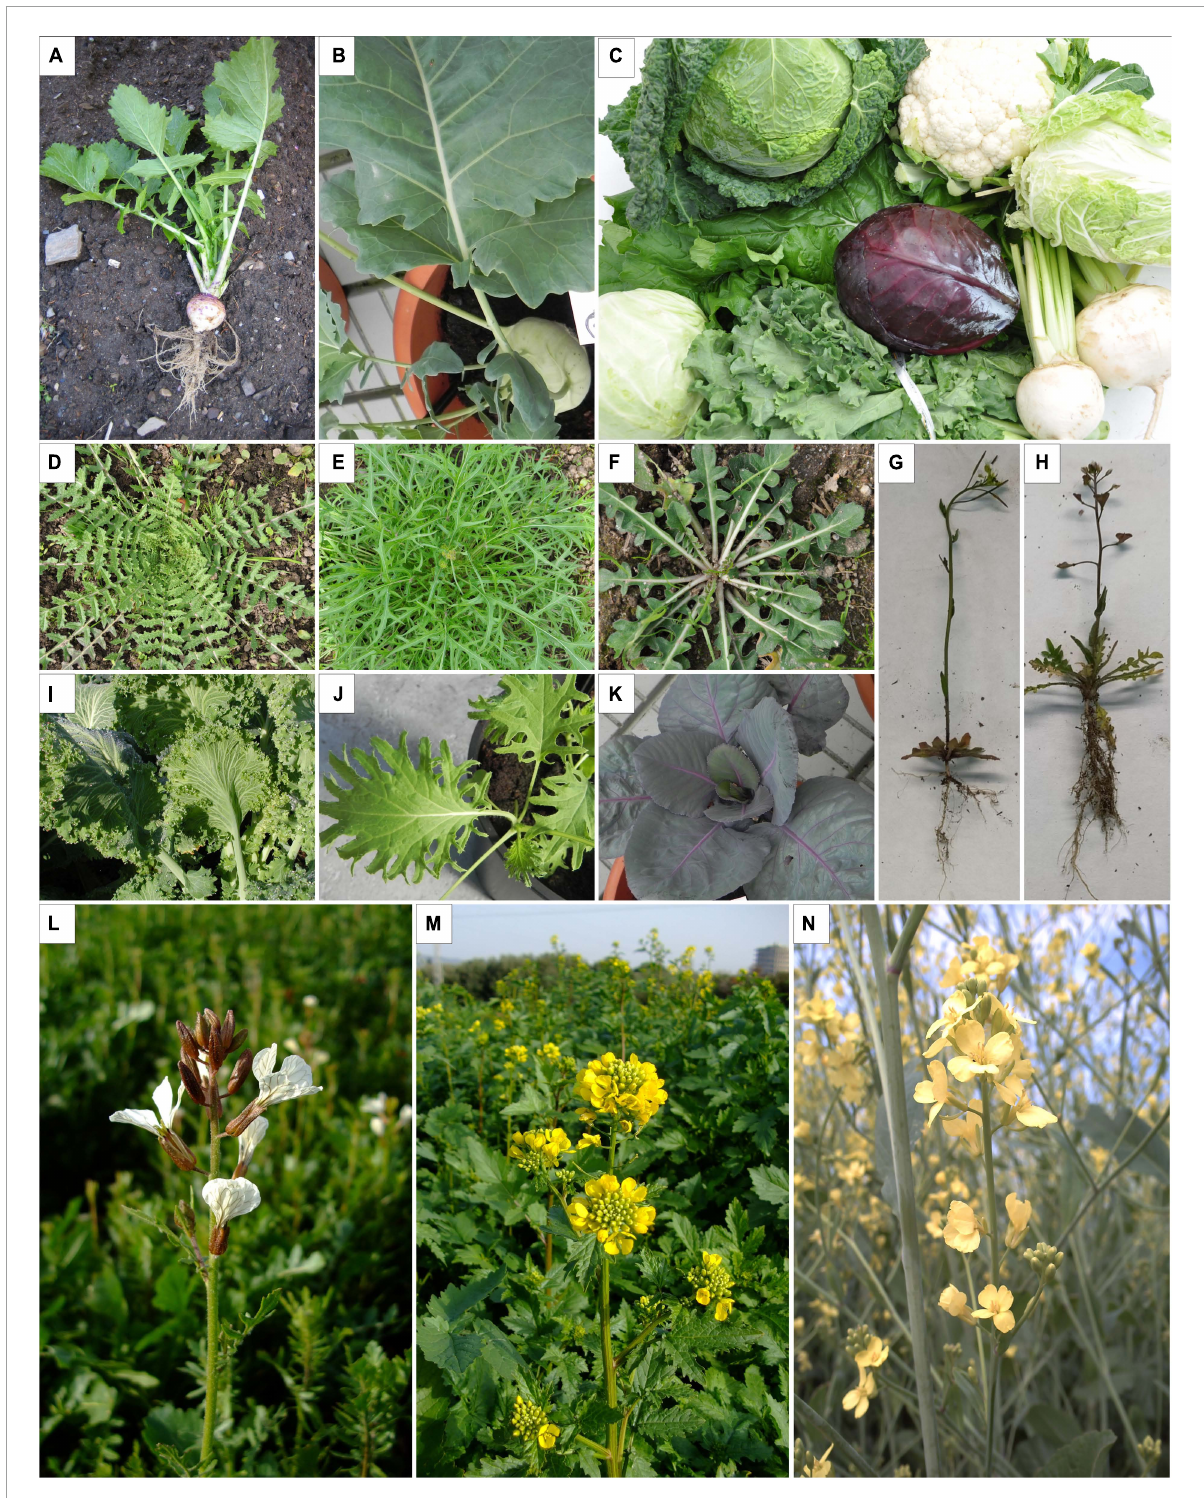
FIGURE1 Composition of images of species belonging to the Brassicaceae family. (A) Brassica rapa (turnip), (B) Brassica oleracea var. gongylodes (Kohlrabi). (C) Different vegetable products belonging to the Brassica genus (cauliflower, cabbage, turnip...), (D) Brassica barrelieri , (E) B. rapa subsp. Nippossinica , (F) Brassica gravinae , (G) Arabidopsis thaliana , (H) Capsella sp., (I) B. oleracea (cabbage), (J) Brassica juncea , (K) B. oleracea subsp. capitata (red cabbage), (L) Eruca vesicaria , (M) Sinapis alba , (N) Brassica carinata